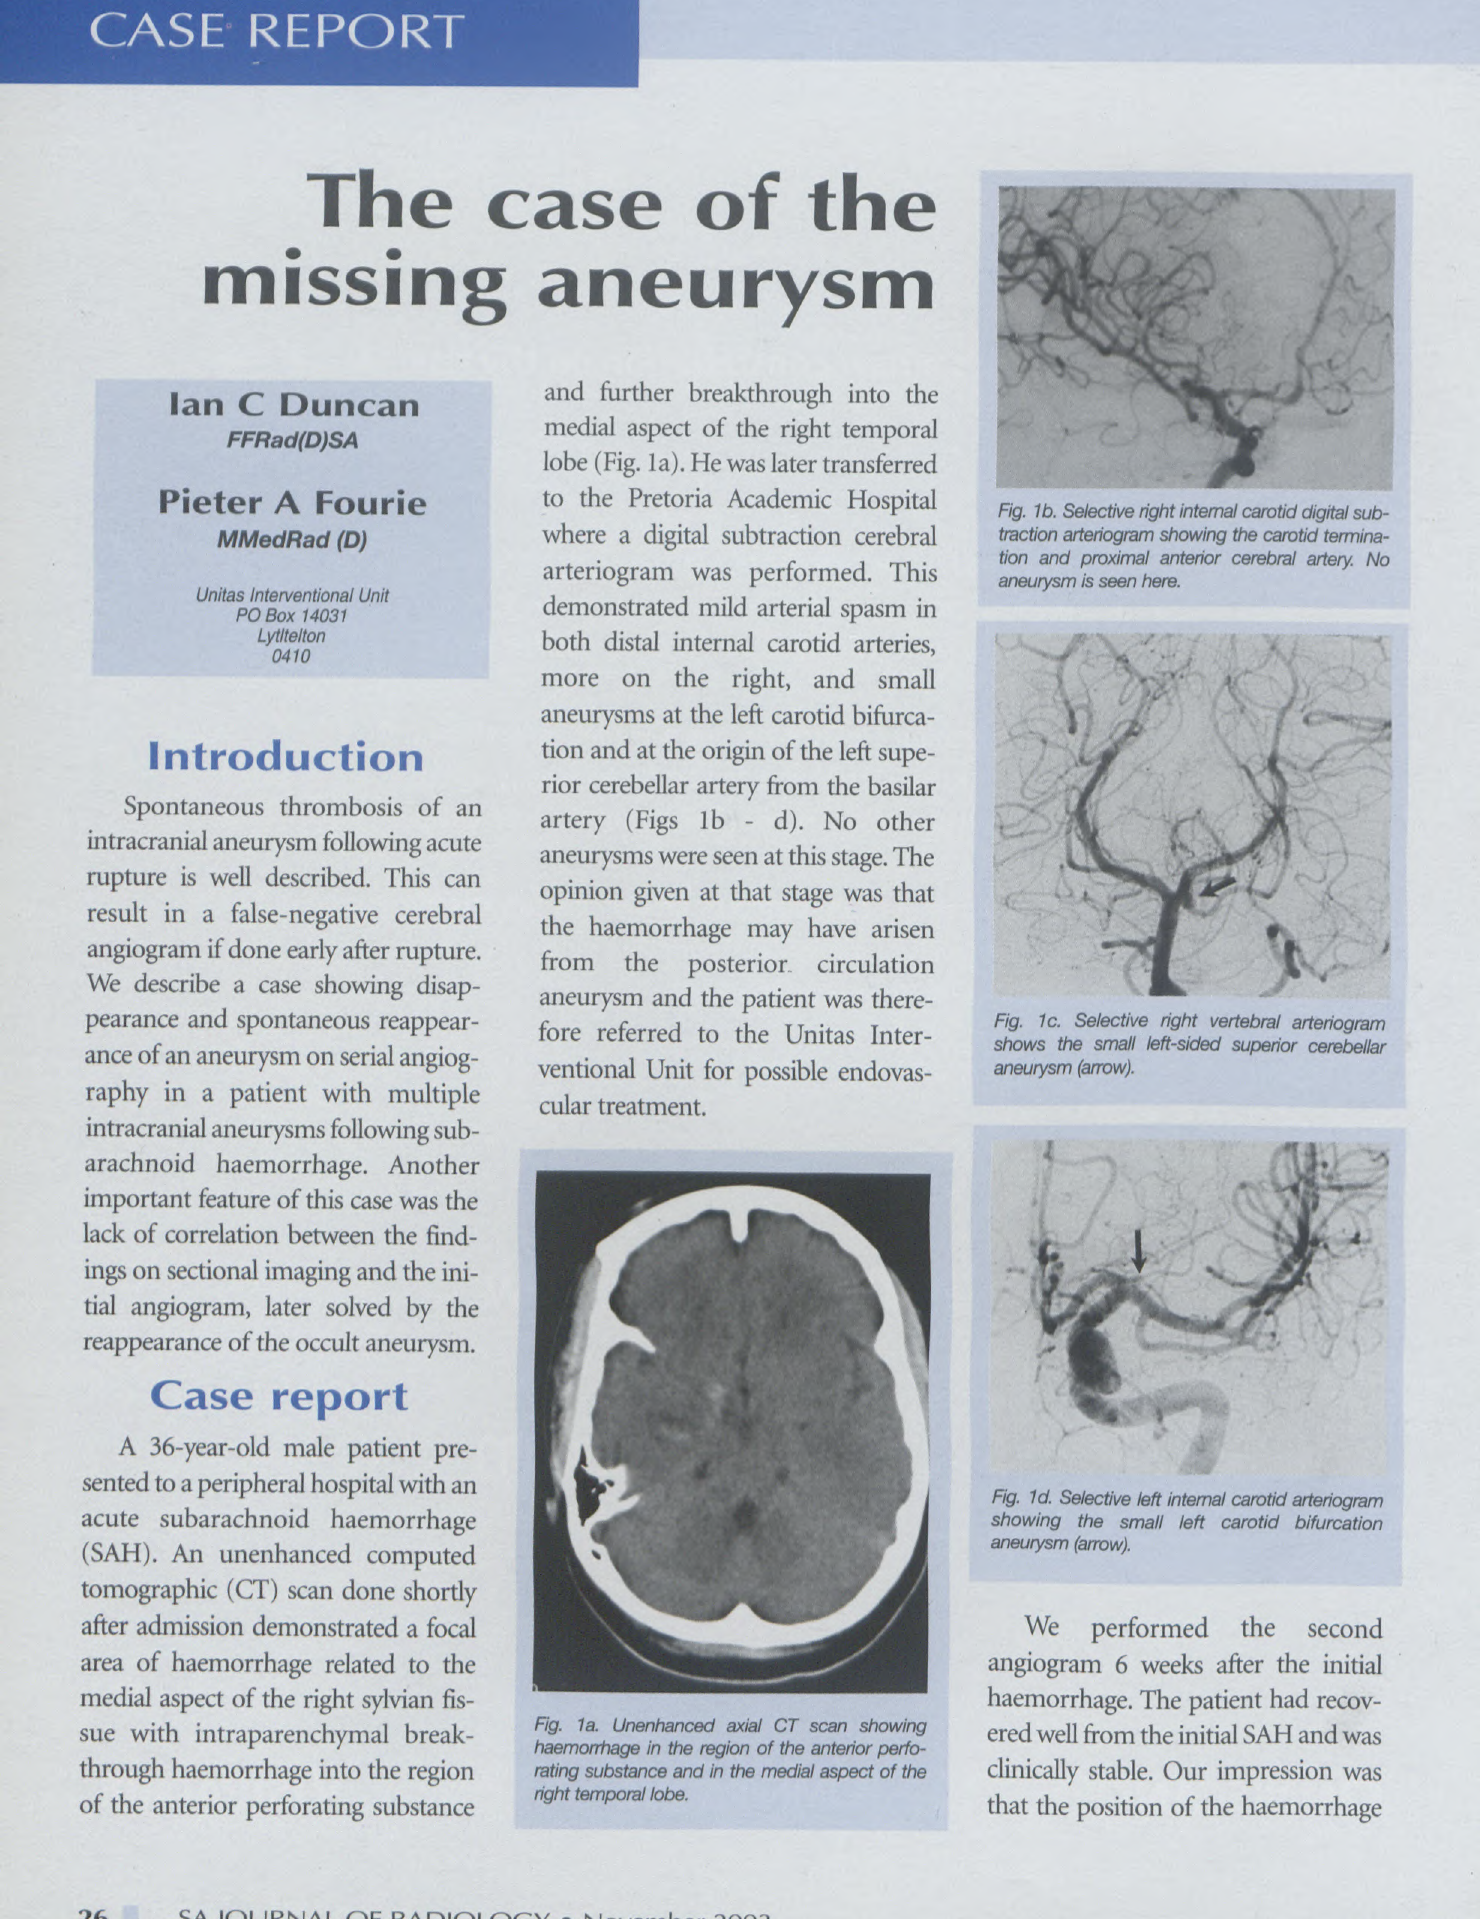
Fig. 1a. Unenhanced axial CT scan showing haemonnage in the region of the anterior perfo- rating substance and in the medial aspeet of the right temporal lobe.